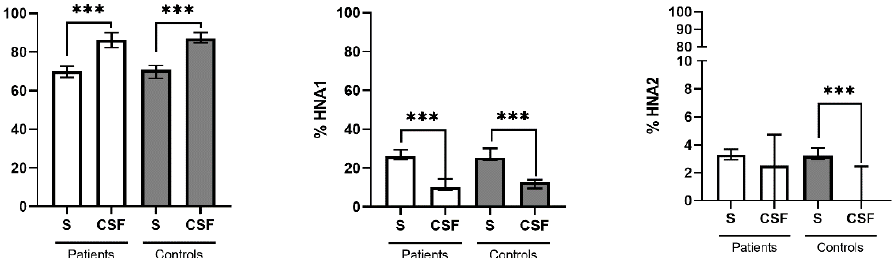
Figure 1. Redox state of albumin in serum versus CSF of MS patients (RRMS and PPMS) and controls. Fractions of HMA (left panel), HNA1 (middle panel), and HNA2 (right panel) in serum (S) and cerebrospinal fluid (CSF) of MS patients (white bars) and controls (gray bars). Data are presented as medians and interquartile ranges. Differences between S and CSF were assessed by Wilcoxon matched-pairs signed rank test. ***, p < 0.001.